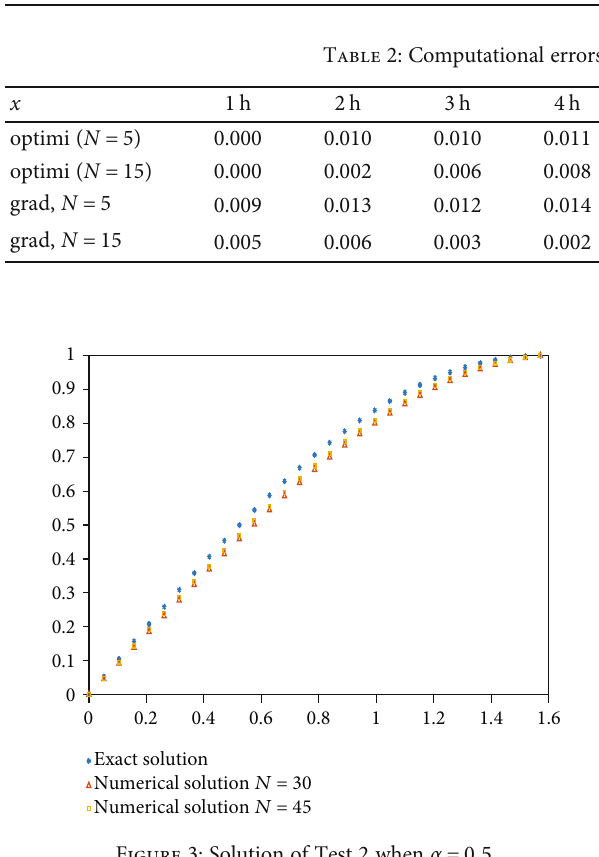
Figure 3: Solution of Test 2 when α = 0 : 5 .